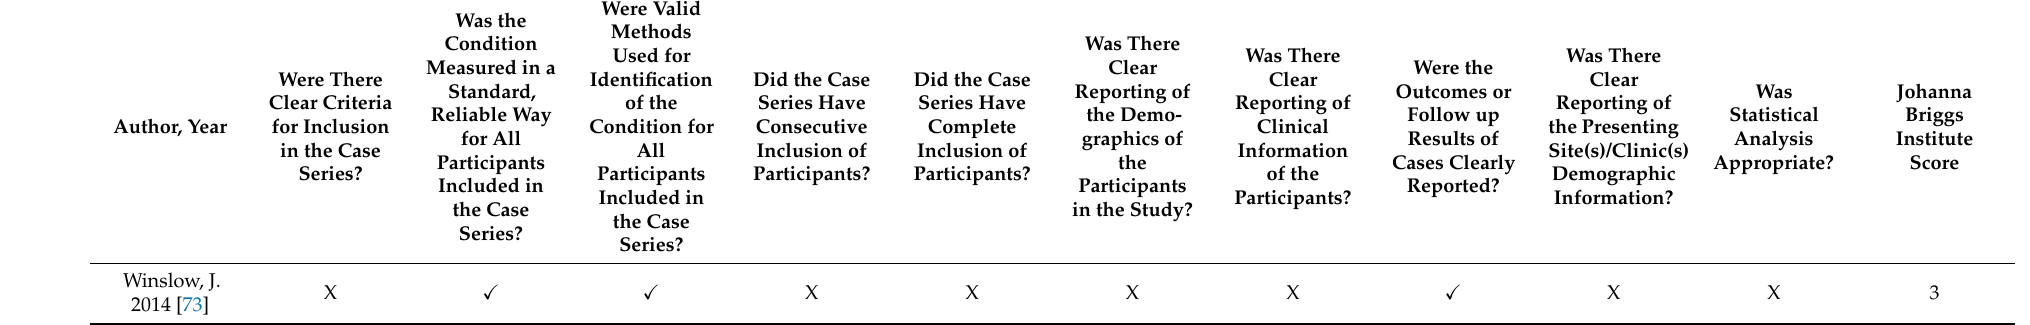
Table 6. Critical appraisal of case